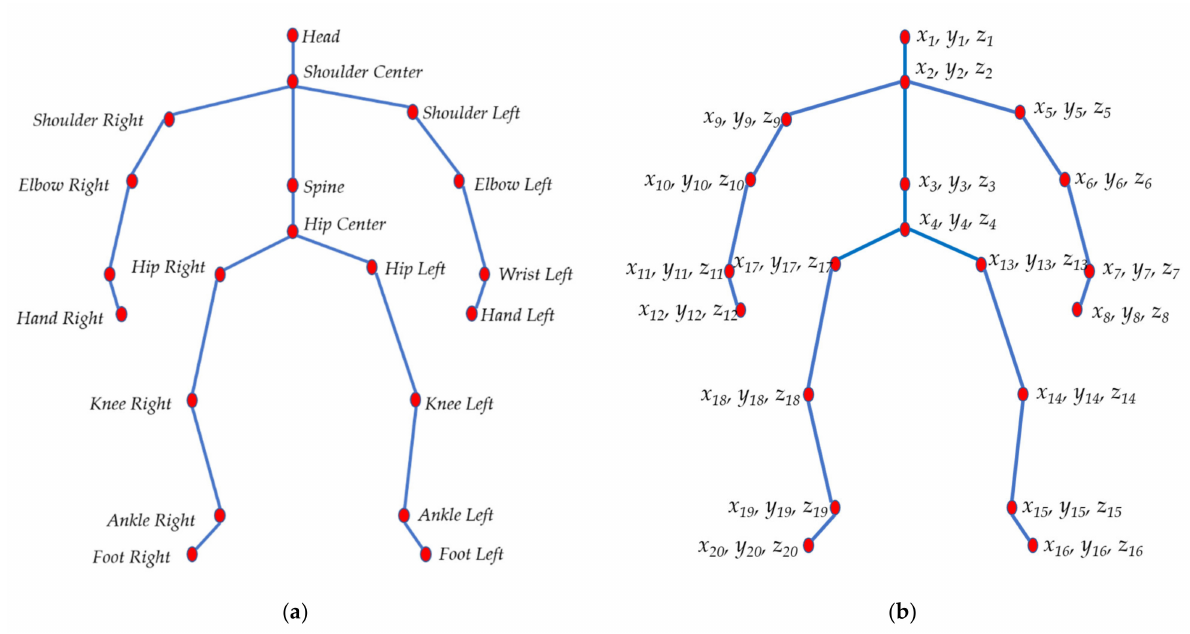
Figure 4. Human skeleton joints views; ( a ) twenty joints names and ( b ) corresponding joints